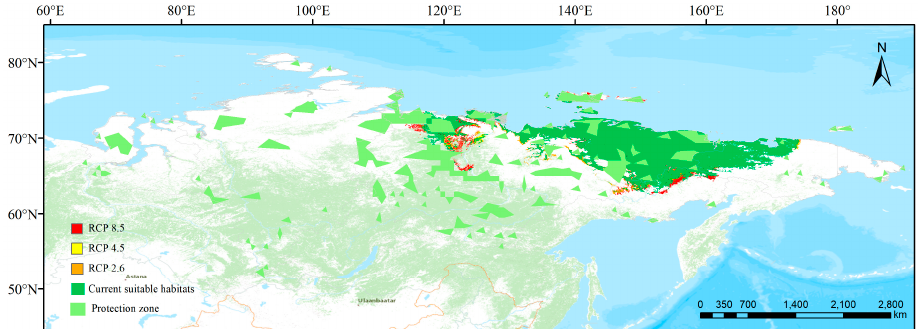
Figure 7. Conservation gaps under different climate scenarios in 2070: red indicates the protection gaps in the case of RCP2.6; yellow represents the protection gaps in the case of RCP4.5; and orange represents the protection gaps in the case of